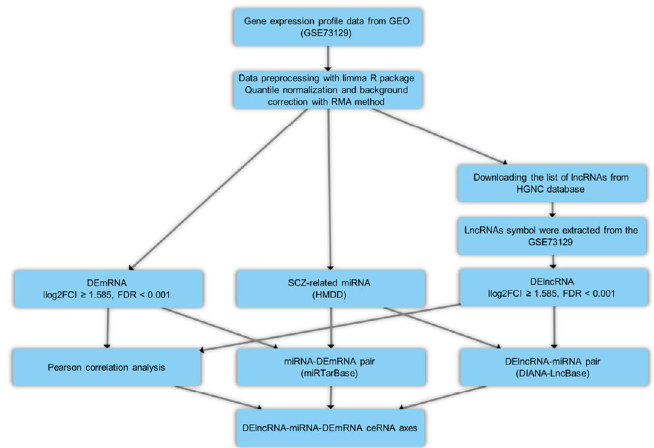
Figure 1. Flow chart of bioinformatics